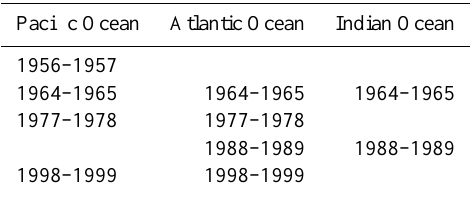
Table A3. Consistent regime shift impacts on fish species across the ocean basins (with greater than five fish species impacted across the regime shift boundary